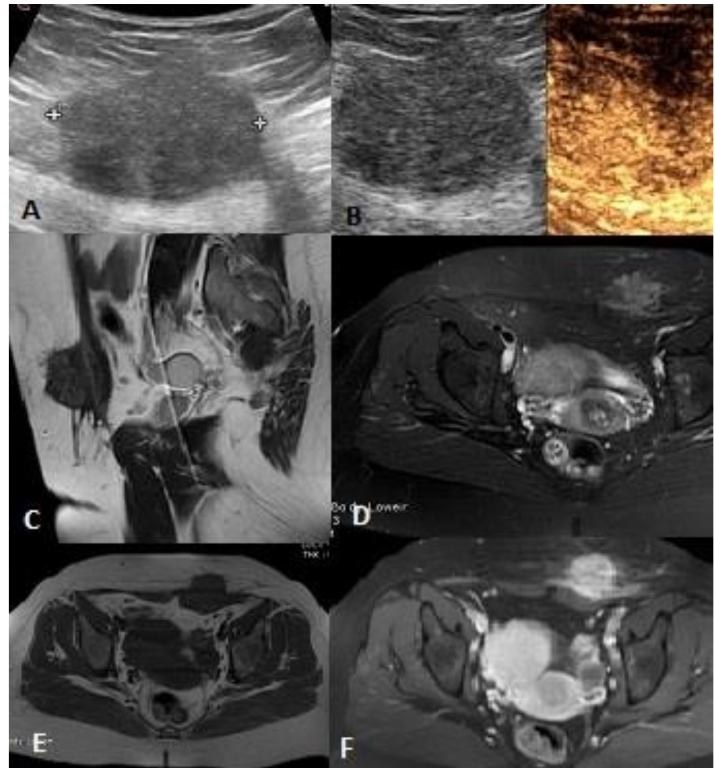
Figure 1. Female, 46 years old, abdominal wall endometriosis: ( A ) US demonstrates a round, heterogeneous, hypoechoic lesion with irregular edges in the deep portion of subcutaneous tissue. ( B ) CEUS reveals numerous vessels with inhomogeneous distribution and avascular areas in the center of the lesion. MRI shows a subcutaneous mass with irregular edges, heterogeneous hypointense in T1- ( C ) and T2- ( E ) weighted images, dishomogeneous high signal in STIR images ( D ) with inhomogeneous enhancement after contrast medium ( F